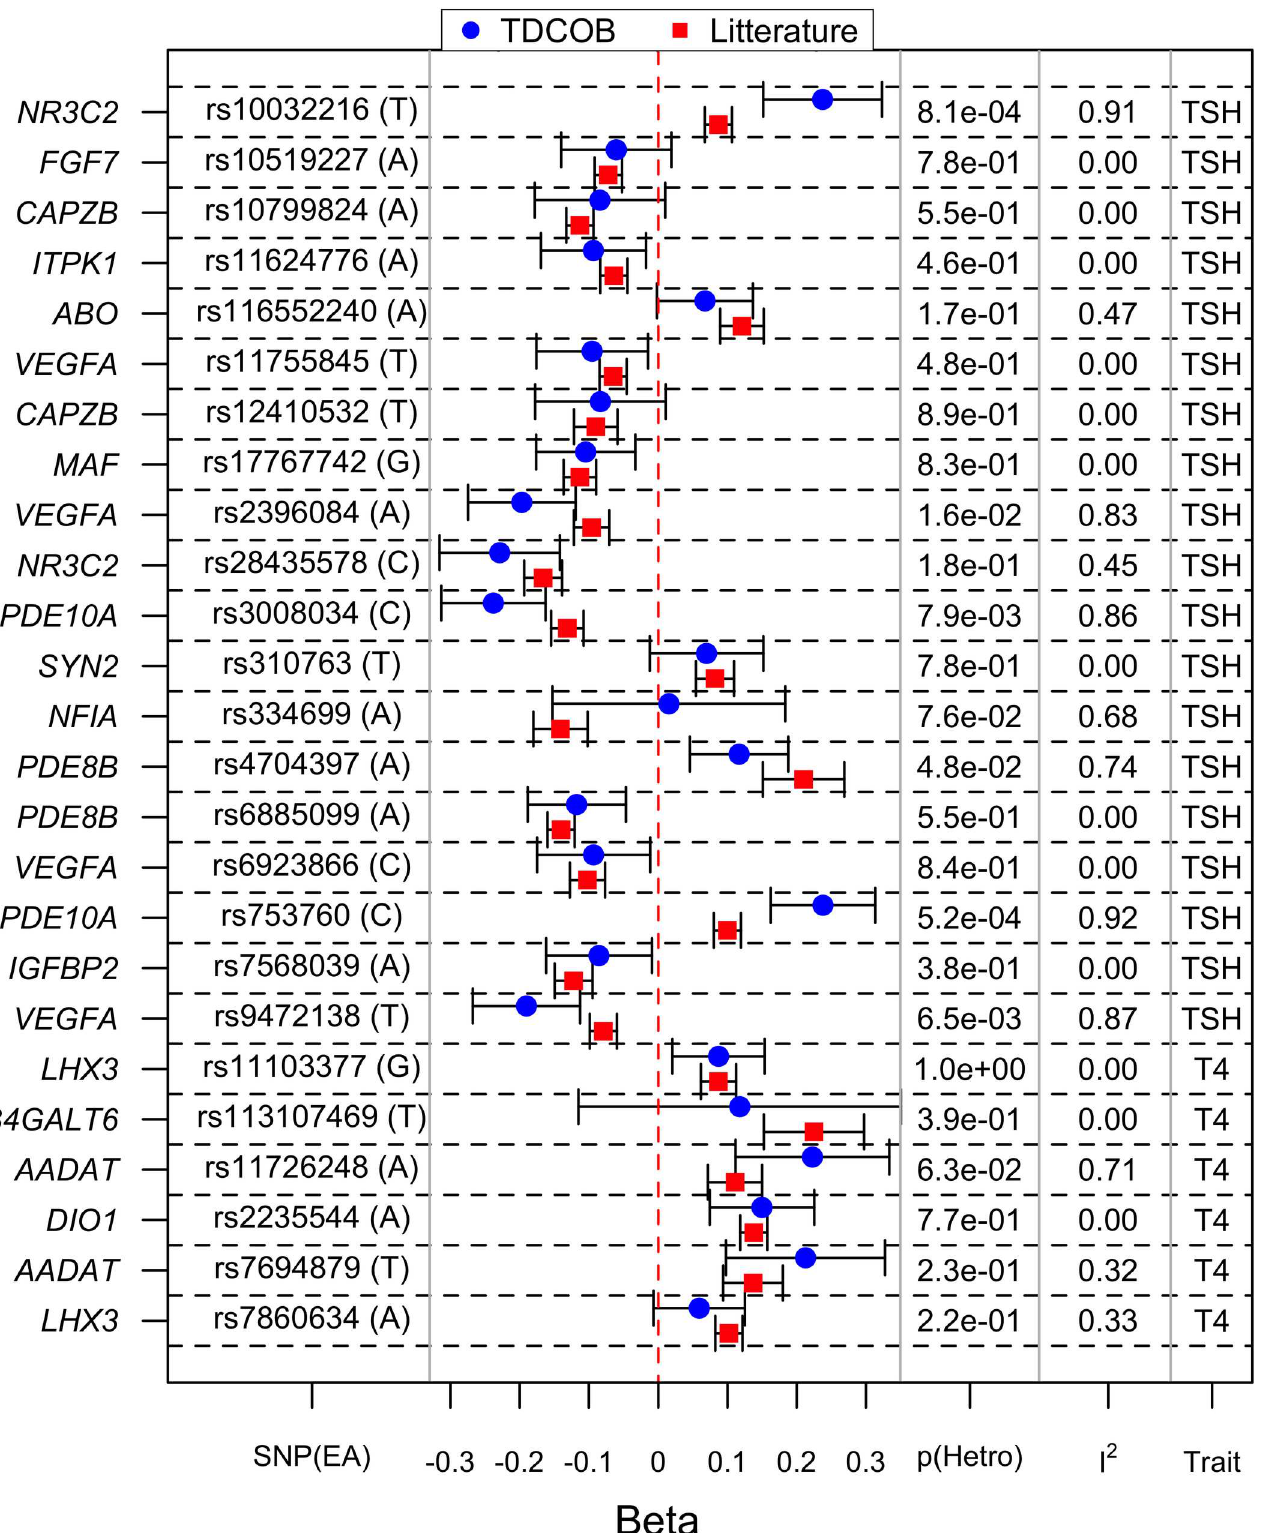
Fig 3. Effects of genetic variants known to associate with plasma TSH or fT4 concentrations. Effects from studies in adults comparedto the effects of the variants in the cohort from the DanishChildhoodObesity Biobank(TDCOB). Effect sizes are shown in standard deviations (SD) of the